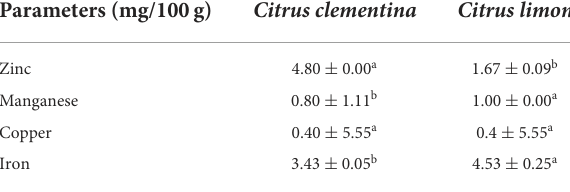
TABLE 3 Micro elemental composition (mg/100g) of whole Citrus clementina and Citrus limon